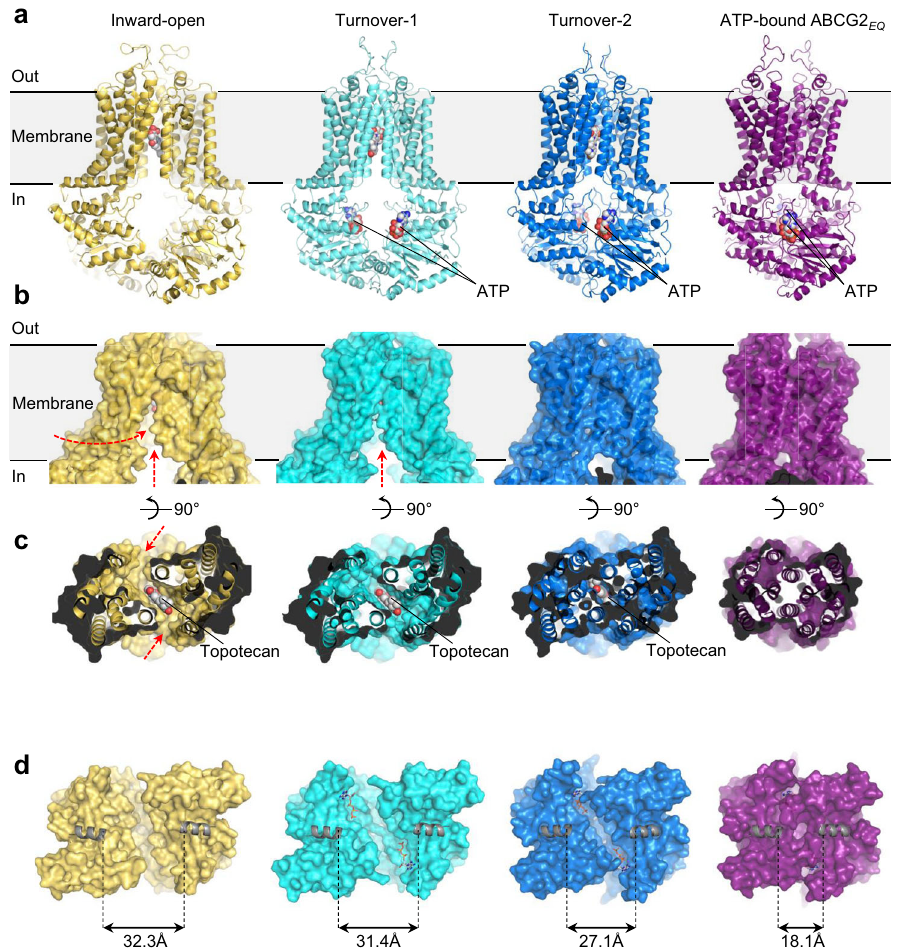
Fig. 2 Coupled NBD and TMD closing. Structures of four states are shown: “ Inward-open ” depicts topotecan- and 5D3-Fab- bound ABCG2 (PDB ID 7NEZ, colored in yellow), the turnover states are from this study, “ ATP-bound ABCG2 E211Q ” depicts the closed conformation (PDB ID: 6HBU, colored in purple). a Ribbon diagrams with substrates and ATP shown as spheres. b Surface representations of ABCG2, emphasizing the distinct TMD conformations. Red arrows depict openings to cavity 1 from within the lipid bilayer or from the cytosol. c View of substrate-binding site in cavity 1 of ABCG2. The TMDs are shown in ribbon and surface representation and viewed from the cytoplasmic side of the membrane. Substrates are shown as spheres and labeled. Red arrows depict openings to cavity 1 from within the lipid bilayer. d Surface representations of the NBDs viewed from the membrane. Bound ATP is shown as sticks. The coupling helices (CpHs) are shown as gray cartoons. Distances between CpHs are